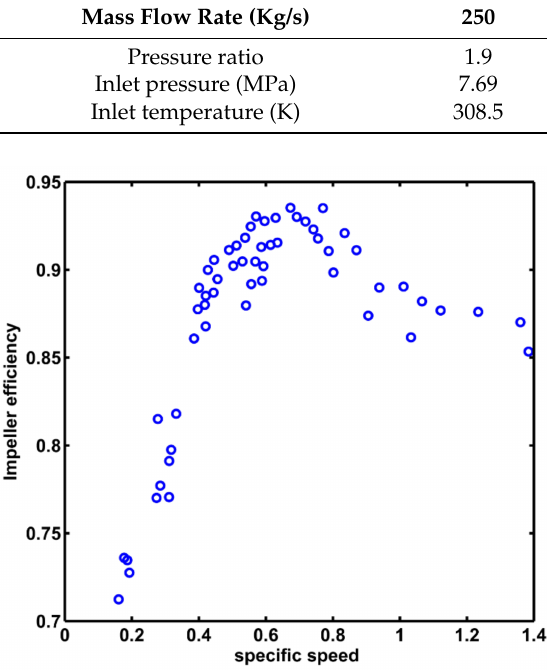
Figure 10. Relation between impeller effciency and specific speed.